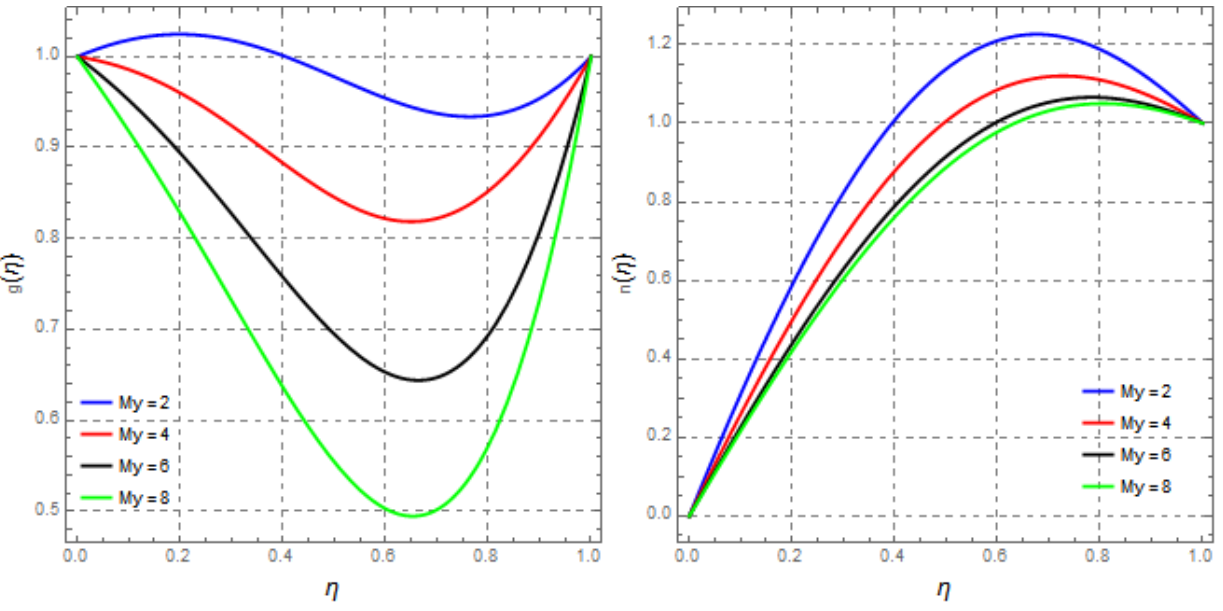
Figure 12. Impact of magnetic field strength M y on velocity component g and magnetic field compo- nent n , keeping S z = − 0.5, M x = − 0.5(for g), M x = − 1.5 (for n ), R m = − 2 (for g ), R m = − 1 (for n ), and S =